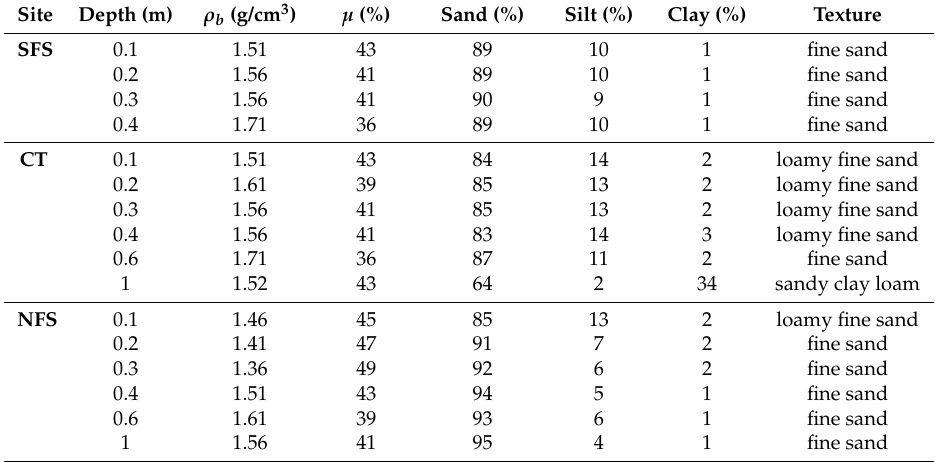
Table 1. Soil properties for each site by depth. ρ b (dry bulk density), µ (soil porosity), percentages of sand, silt and clay and soil texture